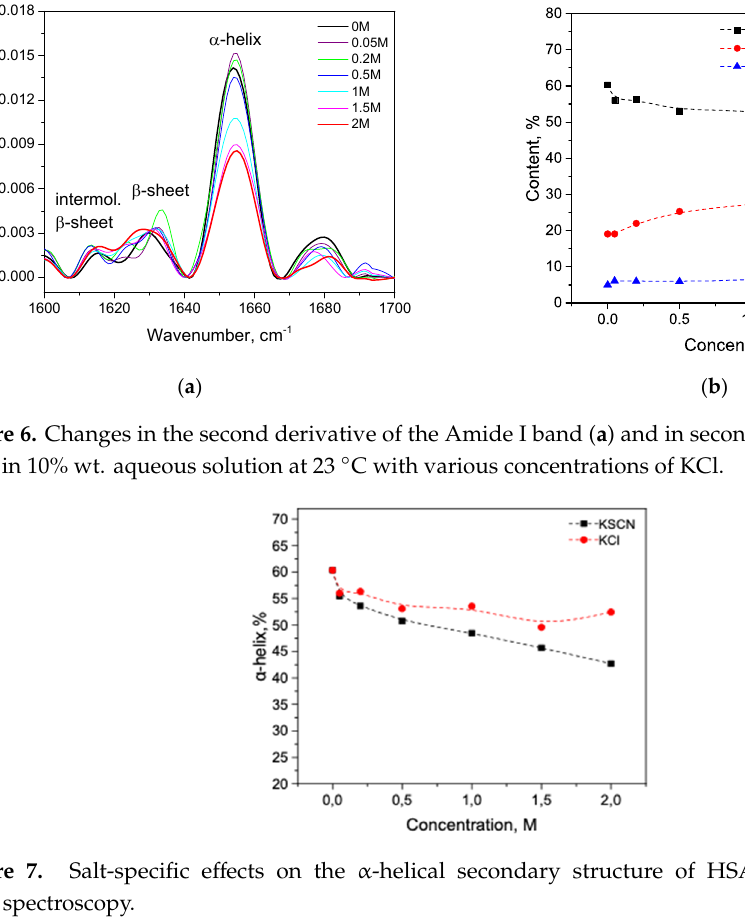
Figure 5. Potassium thiocyanate-induced conformational transition of trypsin at 23 °C. Protein concentration was 20% wt.